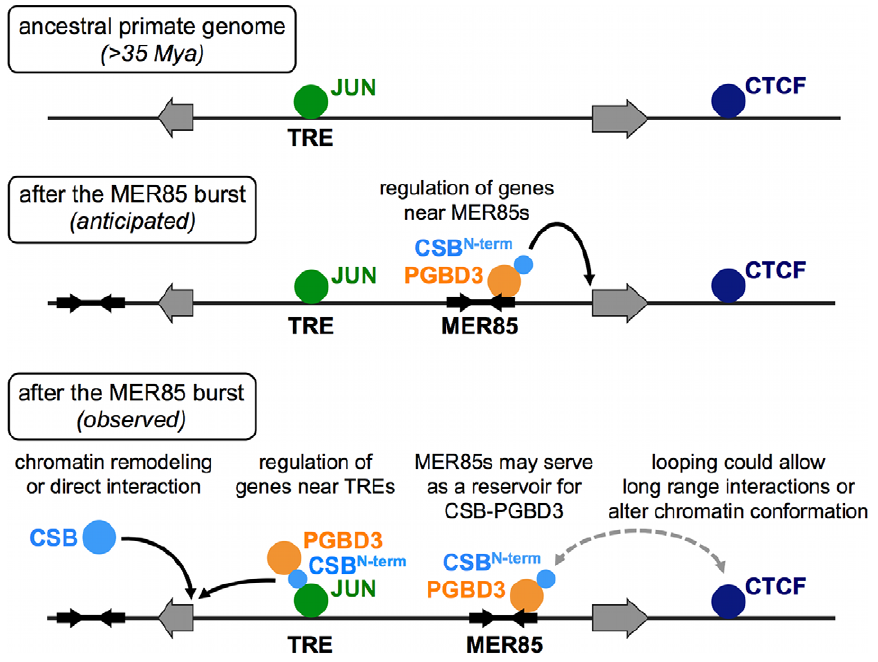
Figure 12. ChIP–seq data suggest multiple roles for the CSB-PGBD3 fusion protein in gene regulation. Top , Transcription factor binding sites before the MER85 replicative burst. Middle , We anticipated that the CSB-PGBD3 fusion protein would bind to MER85 elements throughout the genome and regulate nearby genes through interactions mediated by the N-terminal CSB domain. Bottom , Our ChIP-seq data revealed that CSB- PGBD3 binds over TRE, CTCF, and TEAD motifs, and regulates genes near TRE motifs in CSB-null cells. Full-length CSB may facilitate or suppress these interactions through chromatin remodeling or competition for factors that also bind the N-terminal CSB domain of CSB-PGBD3. The CSB-PGBD3 fusion protein does bind to MER85 elements as anticipated, but these sites may function as a reservoir for CSB-PGBD3 protein or mediate chromatin looping, perhaps by interaction with CTCF.